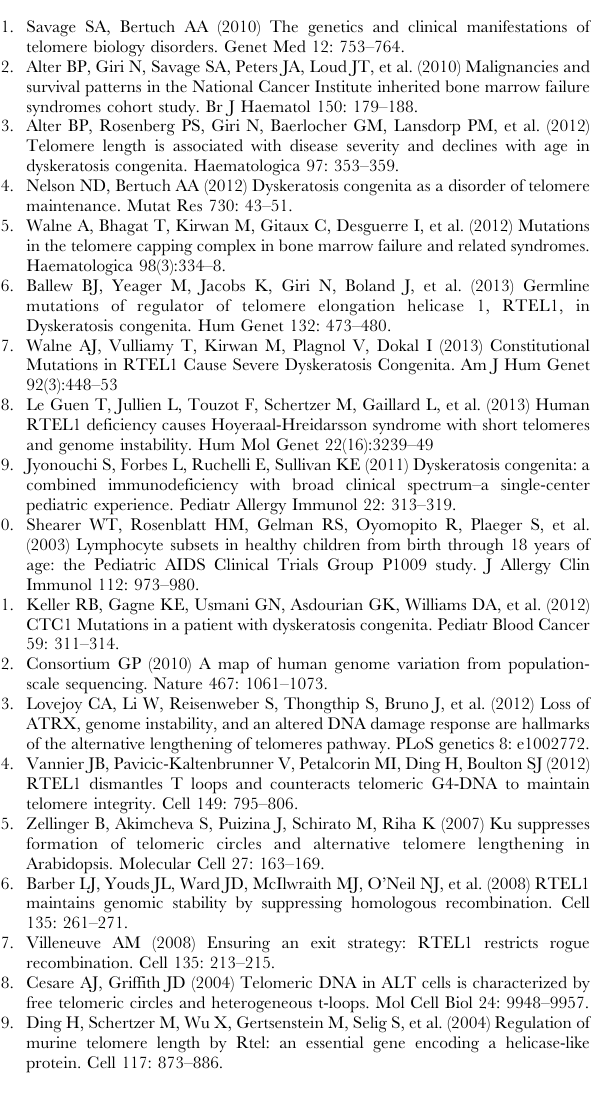
Table S1 Exome variant filtering strategy. Table S2 Exome coverage statistics. Table S3 Variants in telomere- and DDR-related genes and autosomal recessive variants found by whole exome sequencing.